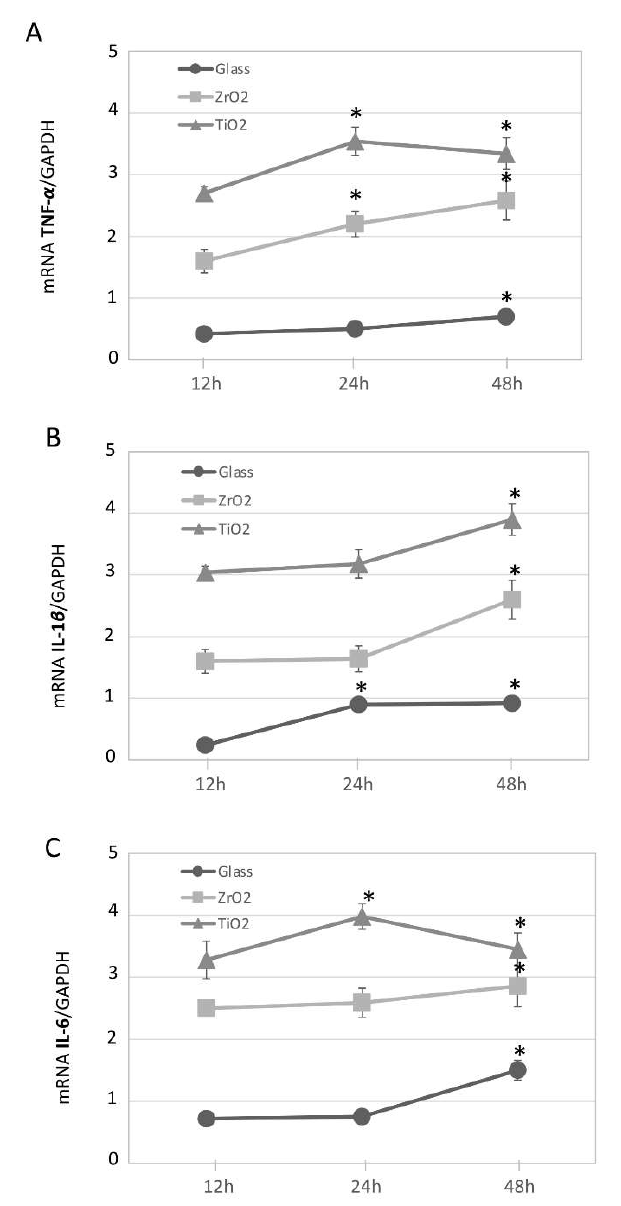
Figure 2. Particle-induced pro-inflammatory gene expression in THP-1 over time. Expression of mRNA for inflammatory cytokines in THP-1 macrophages challenged with titanium, TiO 2 ( ▲ ), zirconia, ZrO 2 ( ◼ ), and glass (●) particles (10 7 particles/mL concentration). qRT-PCR, with normalization to GAPDH using the Ct method analysis, are shown as means ± SD. ( A ) TNF-α , ( B ) IL-1β , ( C ) IL-6 . The symbol * indicates a statistically significant increase in cytokines’ mRNA expression in comparison to non-challenged macrophages. There is a statistically significant interaction between time and material in all cases (two-way repeated measure ANOVA). * p ≤ 0.05.